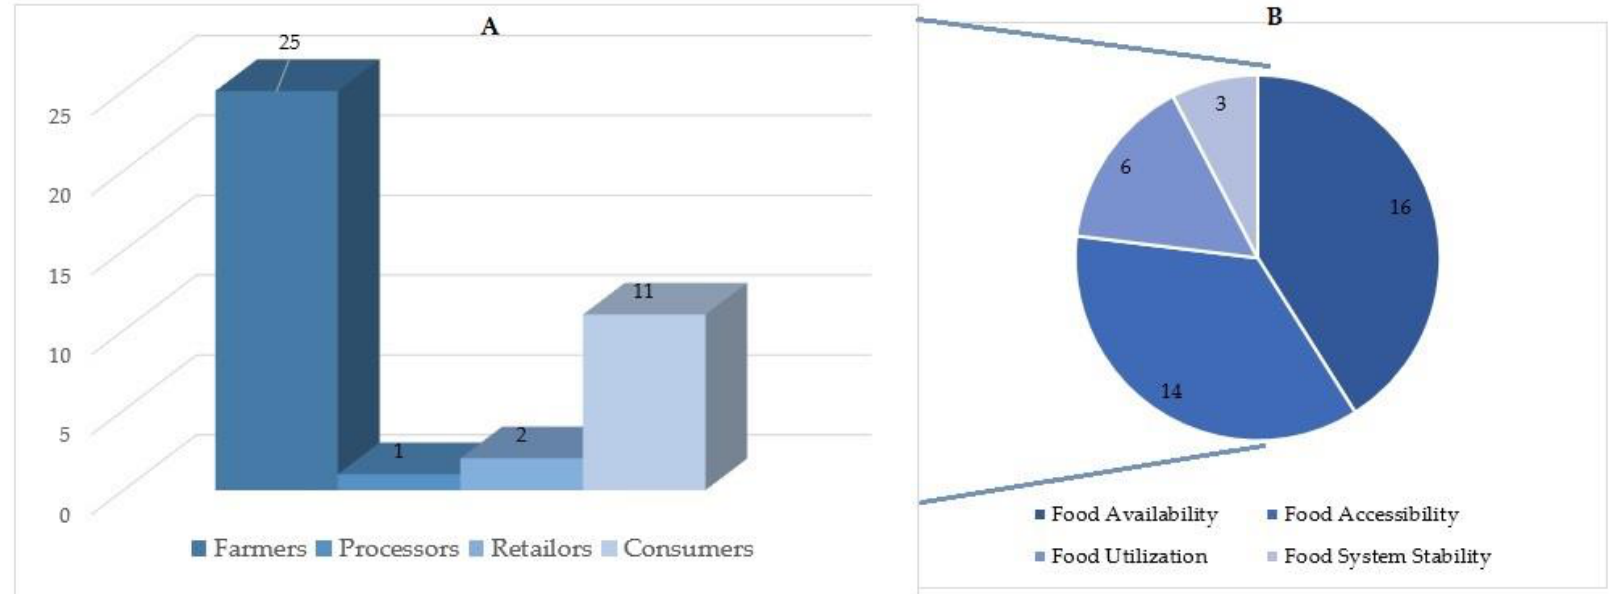
Figure 5. Classifying the reviewed articles based on their focus on ( A ) the food supply chain and ( B ) the food security